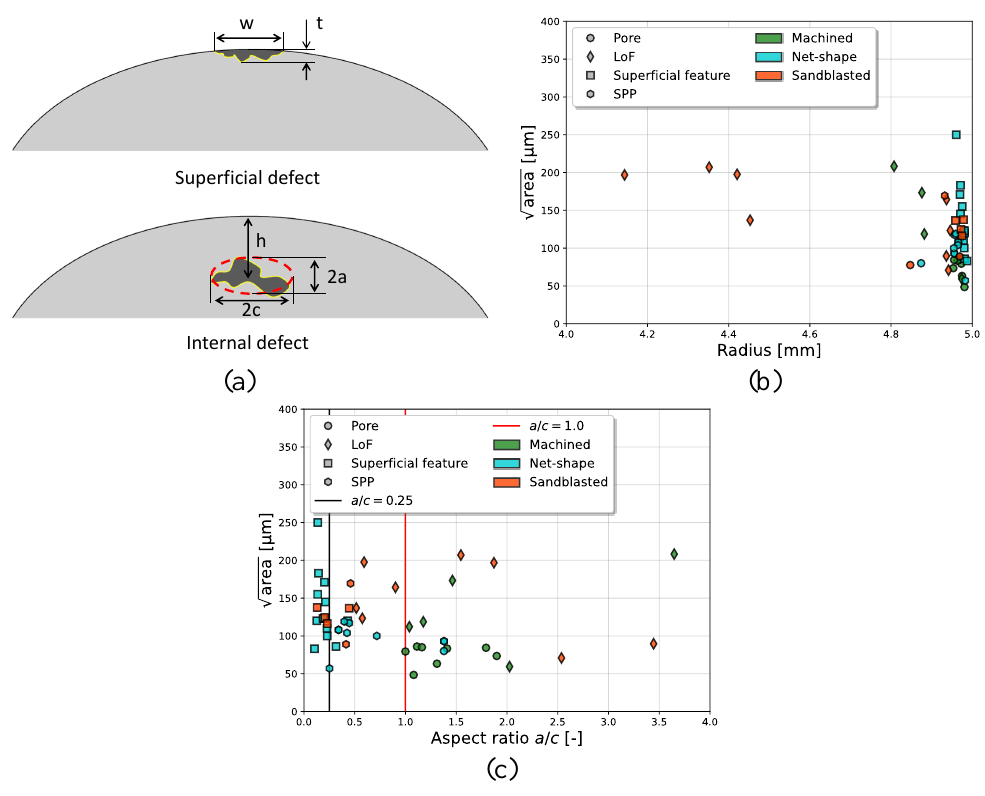
Figure 5. Analysis of the size and geometry of the found defects: ( a ) scheme of the main parameters that define superficial and internal defects; ( b ) dimension of the defects against its radial position and ( c ) dimension of the defects against its aspect